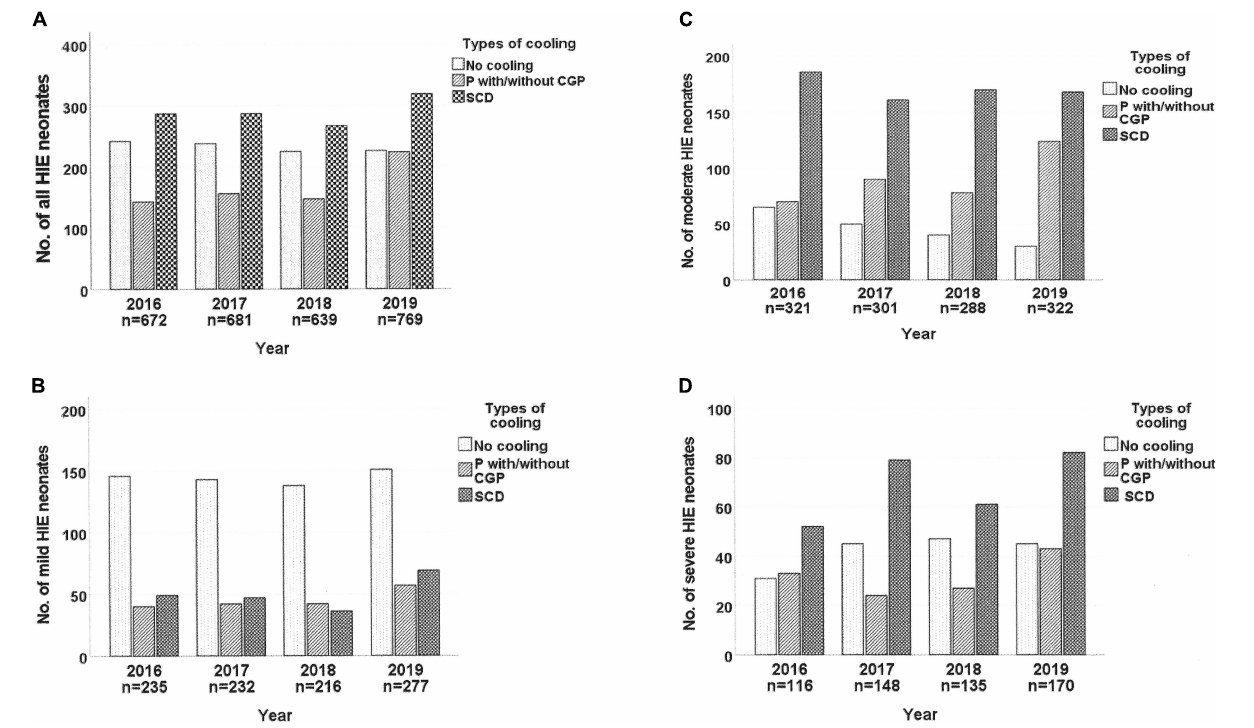
FIGURE 2 | Trends of therapeutic hypothermia used for neonates with hypoxic-ischemic encephalopathy in the MNNR between 2016 and 2019. HIE, hypoxic-ischemic encephalopathy; P with/without CGP, passive cooling with/without uses of cooled gel packs; SCD, servo-controlled